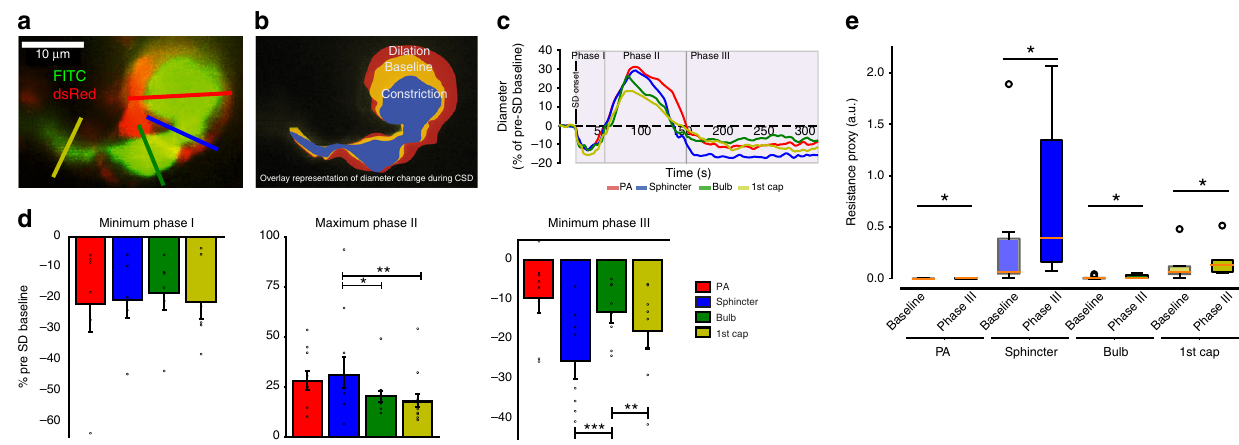
Fig. 6 Sphincters are vulnerable to cortical spreading depolarization. Cortical spreading depolarization was elicited in the posterior part of the somatosensory cortex by microinjection of potassium acetate during imaging of the precapillary sphincter. a Representative maximal intensity projection of an FITC-dextran loaded NG2-dsRed mouse at a precapillary sphincter. Colored lines mark the ROIs for diameter measures. b Overlaid outlines of baseline (yellow), phase II dilation (red), and phase III constriction (blue). c Representative time series of diameter changes within vessel segments during the three phases of CSD. d Summaries of maximal diameter changes within vessel segments during phase I – III of the CSD. During phase II, the PA and sphincter dilated signi fi cantly more than the fi rst order capillary. During phase III, the sphincter constricted signi fi cantly more than the PA and the bulb. Datasets were analyzed via LME models, followed by Tukey post hoc tests for pairwise comparisons (phase II data were log-transformed to ensure homoscedasticity). e Boxplot summary of the estimated fl ow resistances at vessel segments at baseline and during phase III of CSD. Paired Wilcoxon signed rank tests were used to establish the difference ( p < 0.05) before and during CSD phase III. n = 6 mice for phase I, 9 mice for phase II and 8 mice for phase III, ±SEM. The box extends from the lower to upper quartile values of the data, with a line at the median. The whiskers extend from the box to show the range of the data. Flier points are those past the end of the whiskers. In each fi gure, signi fi cance codes * p < 0.05, ** p < 0.01, and *** p < 0.001. Source data are provided as a Source Data fi